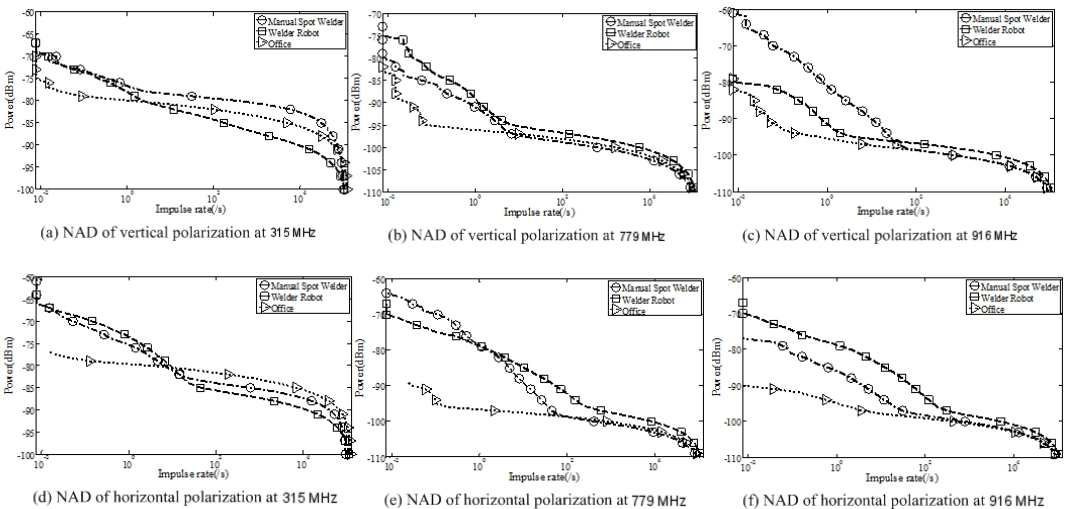
Figure 7. Noise amplitude distribution (NAD) results. ( a ) NAD of vertical polarization at 315 MHz; ( b ) NAD of horizontal polarization at 315 MHz; ( c ) NAD of vertical polarization at 779 MHz; ( d ) NAD of horizontal polarization at 779 MHz; ( e ) NAD of vertical polarization at 916 MHz; ( f ) NAD of horizontal polarization at 916 MHz.